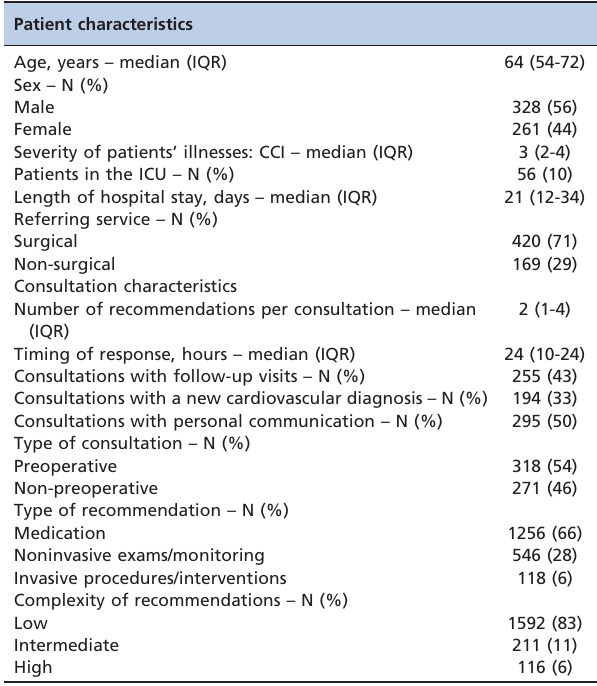
Table 1 - Characteristics of patients and consultations selected for the